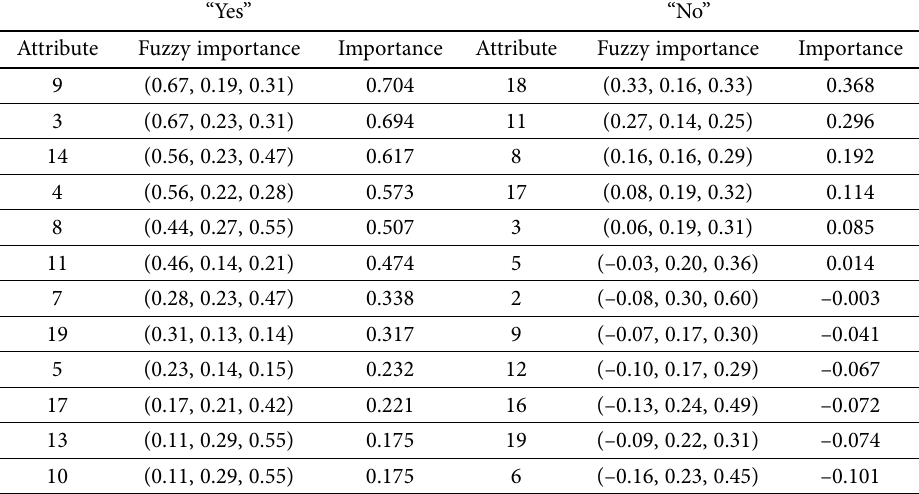
Table 12. Fuzzy importance and crisp importance of attributes related with the experience – Hotel 1 “Yes” “No” Attribute Fuzzy